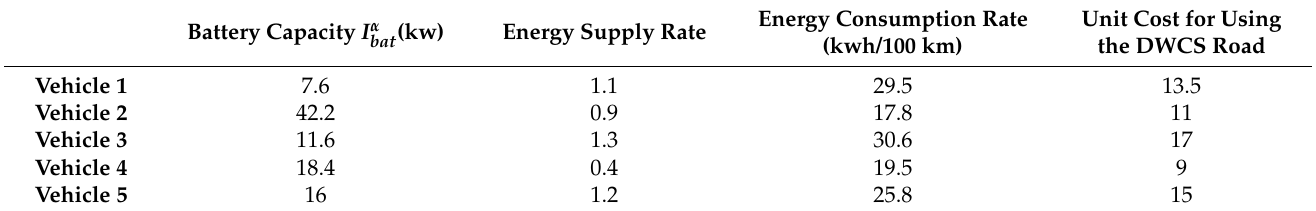
Table 5. Vehicle data.